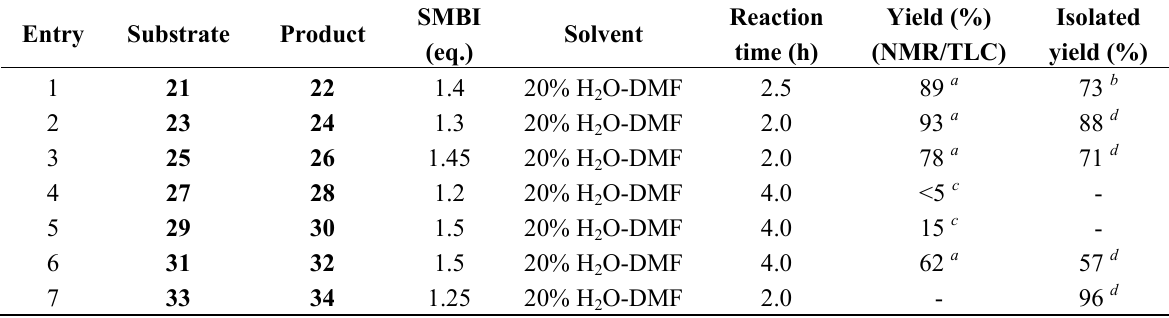
Table 3. Bromination conditions for purine